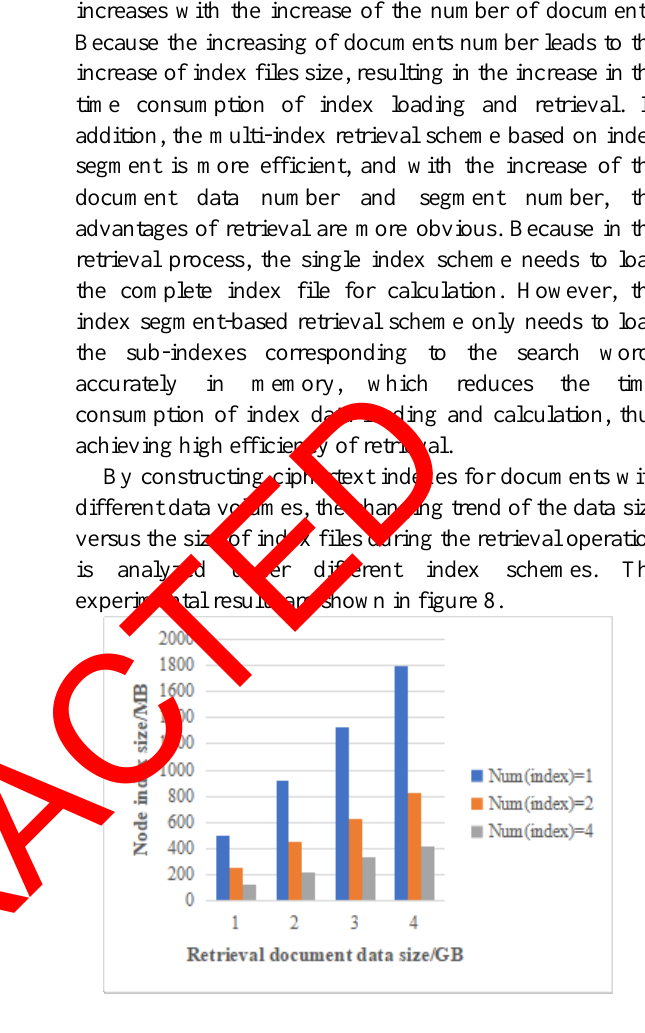
Figure 8. Index file size comparison during